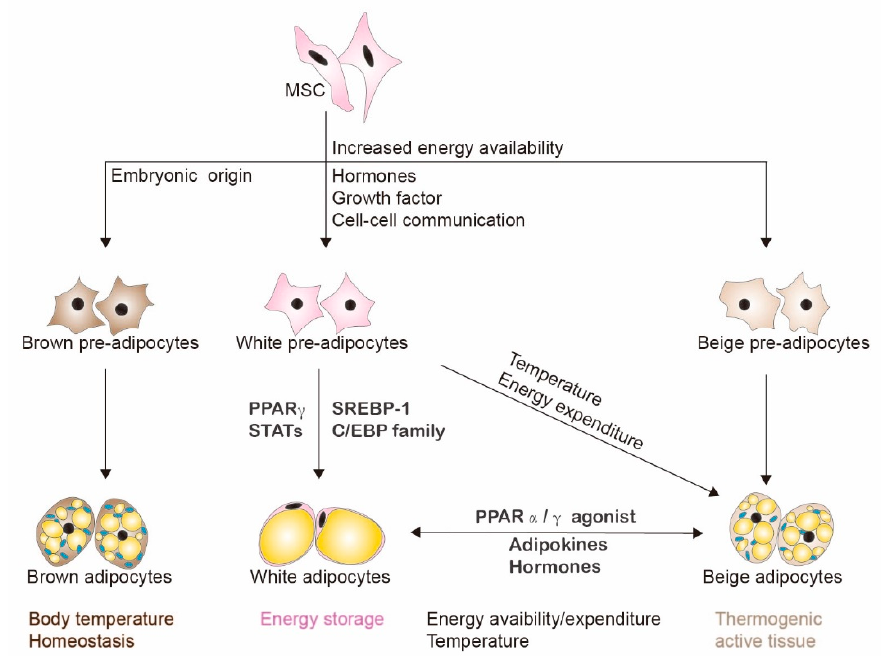
Figure 1. Adipogenesis and di ff erent types of adipose tissue. Adipocytes can be divided into three di ff erent types depending on their origin, metabolic activity and morphological features. These are brown (BAT), white (WAT) and beige adipocytes. Mesenchymal precursors are committed and di ff erentiate into pre-adipocytes, then further mature into adipocytes of a particular lineage influenced by various transcription factors, cell to cell communication, and extracellular signaling. WATs can also be transformed into beige adipocytes and vice versa, influenced by energy availability, temperature and extracellular